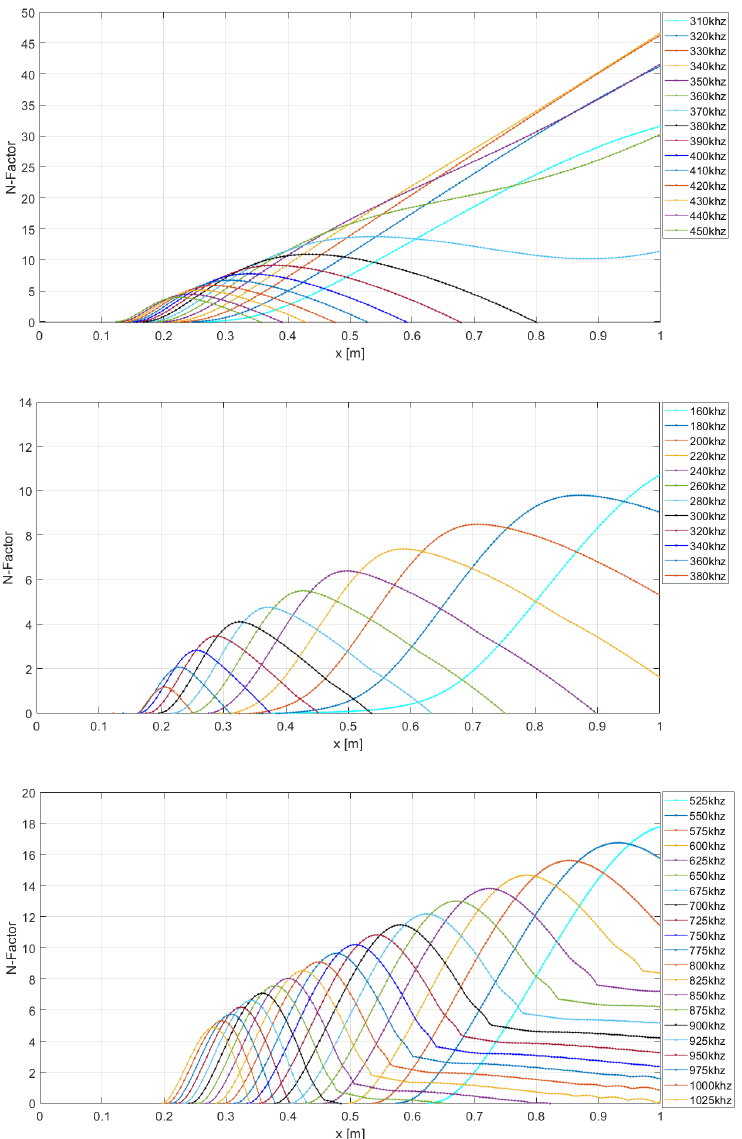
Figure 3. LPSE results— Upper : Notre Dame tunnel conditions 4 m flared cone. Middle : Notre Dame tunnel conditions straight cone. Lower : HIFiRE flight conditions straight